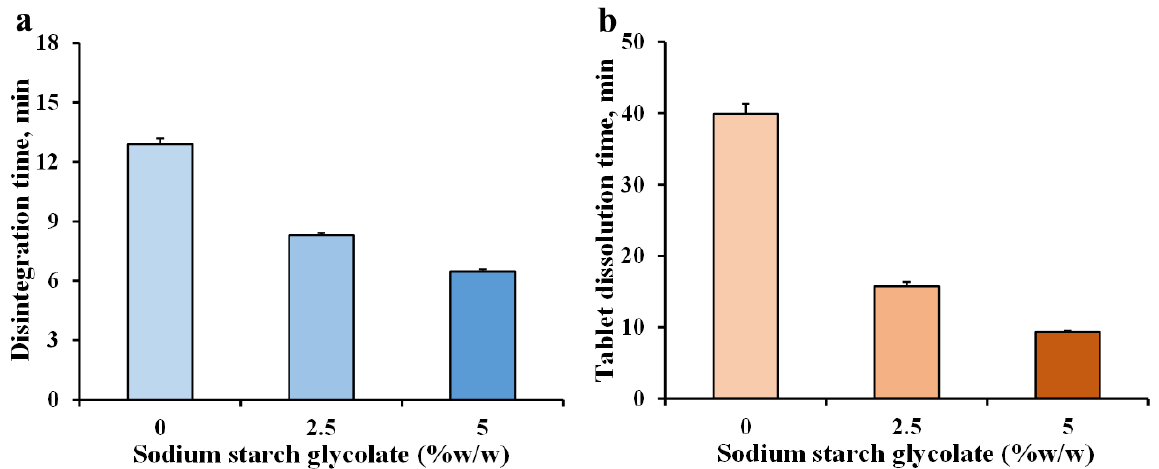
Figure 3. Effect of sodium starch glycolate on disintegration time ( a ) and tablet dissolution time ( b ) of fluconazole tablets. Each value is the mean ± S.D., n = 3.